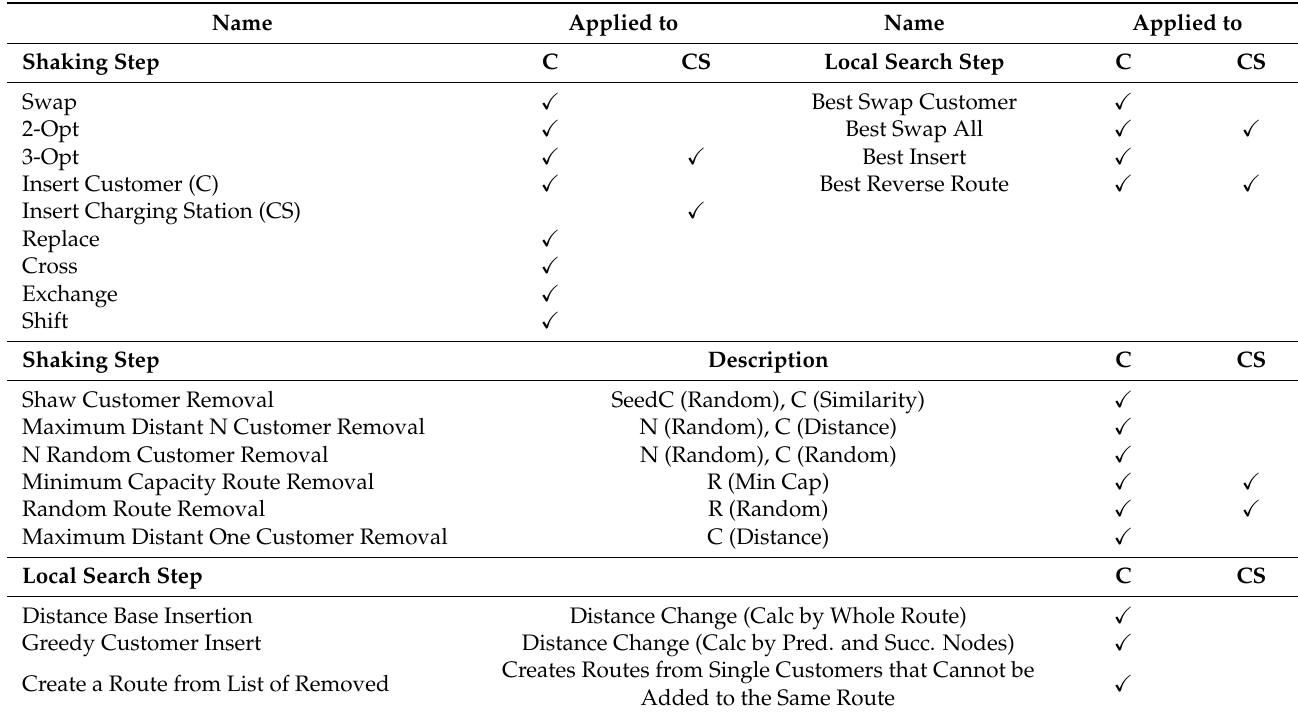
Table 3. VNS neighborhood